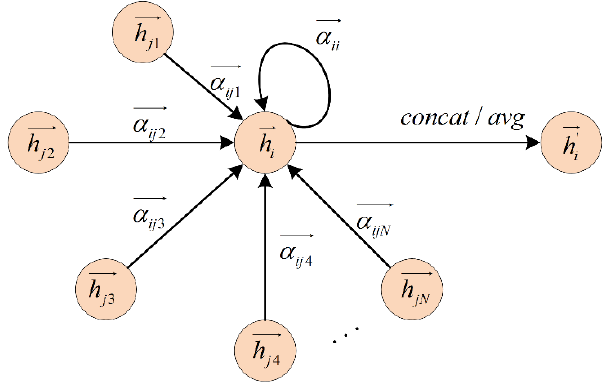
Figure 8. The example of using graph attention layer operation for neighbors around node 1, where → h i ∈ R N × F represents the features of node i , N is the number of nodes, and F is the number of features. ℎ (cid:3114)(cid:4593) (cid:4652)(cid:4652)(cid:4652)⃗ is the update of the hidden feature.